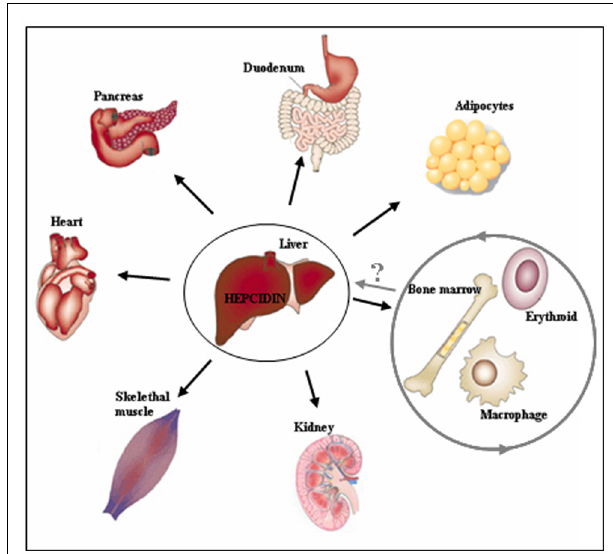
FIGURE 2 | Beyond the hepatocytes. The regulatory cues controlling iron metabolism are centered in the liver where hepatocytic- Hfe directs the production of the liver iron hormone hepcidin.The lack of hepatocytic- Hfe leads to inadequate production of hepcidin which results in increased iron uptake by the duodenum, iron release from macrophages into the circulation and deposition of the excess of iron in numerous tissues causing systemic iron overload (indicated by black arrows).The actions of the Hfe in extra-hepatocytic cells, such as erythroid and macrophages (indicated by grey circle), have recently been proposed suggesting for previously neglected functions of the Hfe in these cells.These selective extra-hepatocytic functions of Hfe are involved in the control of local, tissue-specific iron homeostasis however their impact on systemic iron regulation and the relevance for the Hfe-HH associated pathologies remains still to be